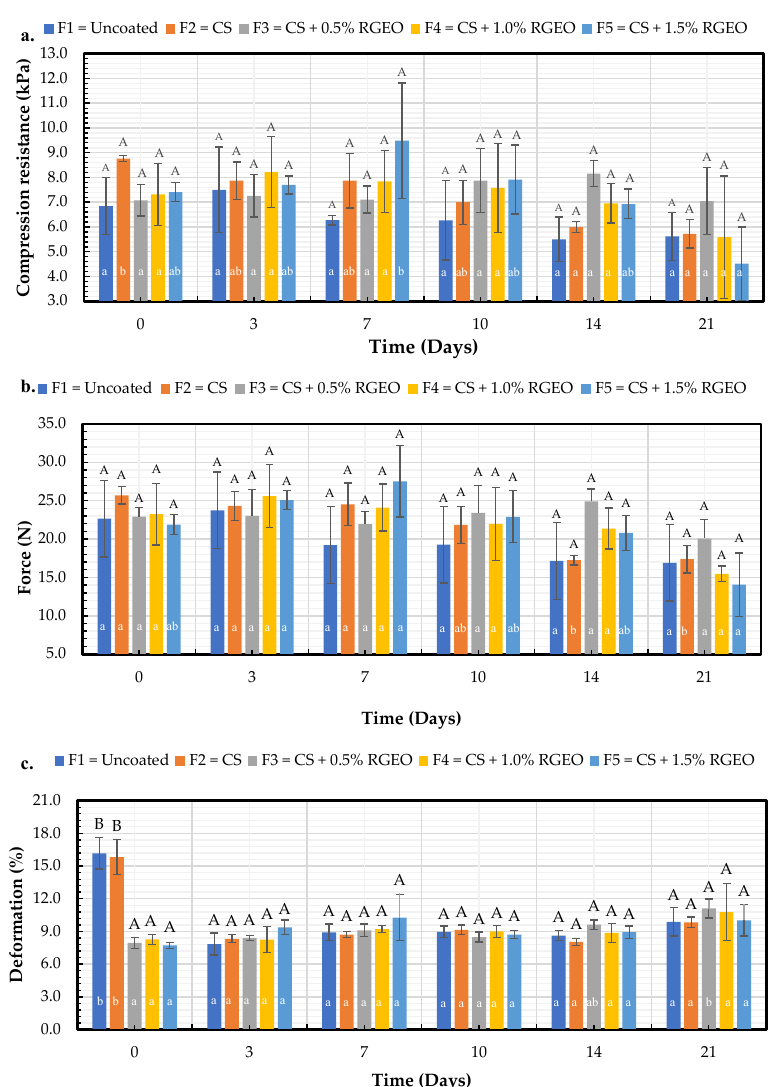
Figure 6. Evolution of: ( a) Compression resistance (kPa), ( b ) Force (N) and ( c ) Deformation (%), in pears with chitosan (CS) and oil treatments (RGEO): F1 = control, F2 = CS, F3 = CS + RGEO 0.5%, F4 = CS + RGEO 1.0%, and F5 = CS + RGEO 1.5%. According to the ANOVA test, mean values and intervals of Duncan test for treatments and Fisher for days with 95%. Different lowercase letters (a, b, c) indicate significant differences between days according to the LSD Fisher test for each treatment in a confidence interval of 95%. In contrast, different uppercase letters (A, B, C) indicate significant differences between treatments for each day according to the Duncan test in a confidence interval of